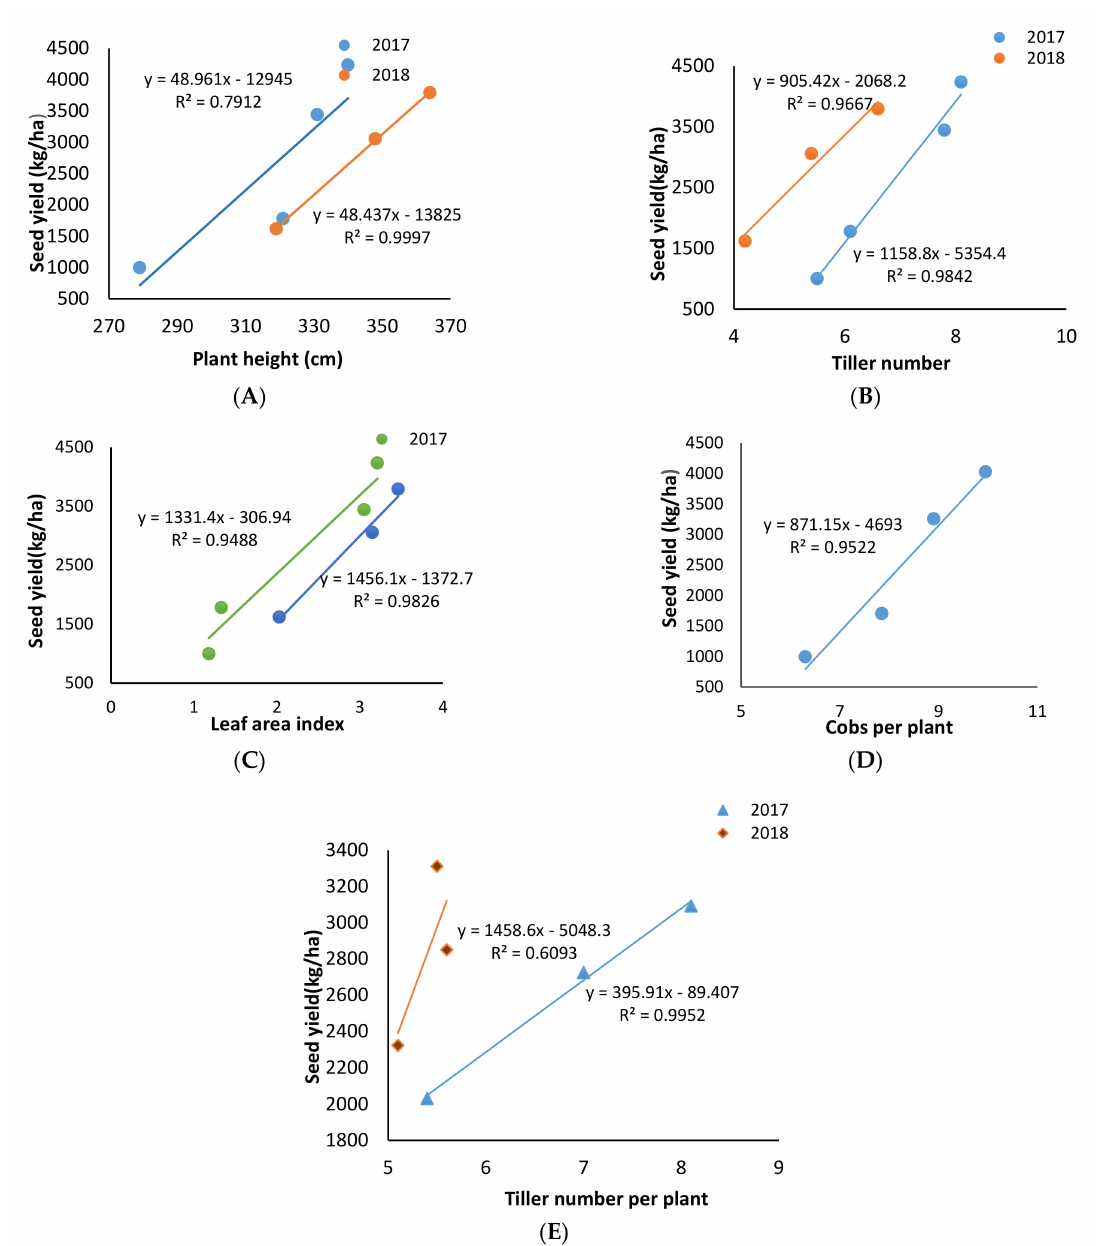
Figure 2. ( A ) Correlation between teosinte plant height and seed yield using main effect means of different sowing dates. ( B ) Correlation between teosinte tiller number and seed yield using main effect means of different sowing dates. ( C ) Correlation between teosinte leaf area index and seed yield using main effect means of different sowing dates. ( D ) Correlation between teosinte cobs per plant and seed yield using main effect means of different sowing dates (average mean of both years). ( E ) Correlation between teosinte tiller number and seed yield using main effect means of different cutting management. The circles, triangles and diamonds in different colours in figure ( A – D ) are the mean values of seed yield with respect to plant height, tiller number, leaf area index, cobs per plant against sowing dates and in figure ( E ) they represent the mean value of seed yield with respect to tiller umber per plant against different cutting